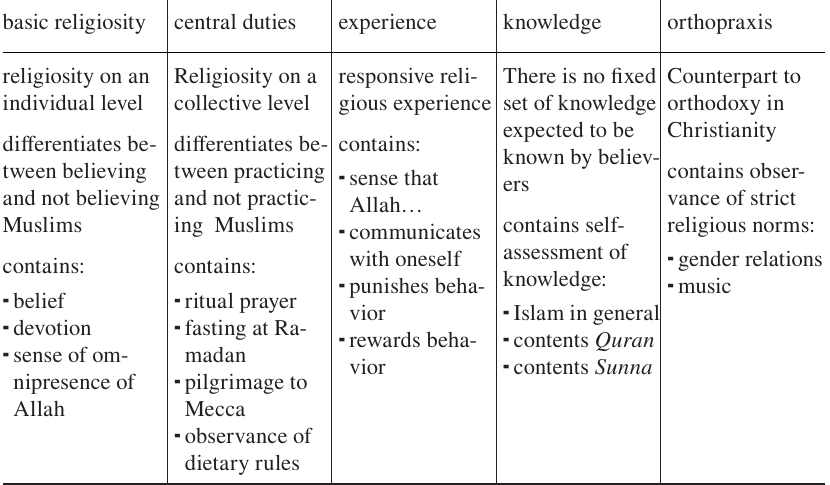
Table 5 : The five dimensions of Muslim